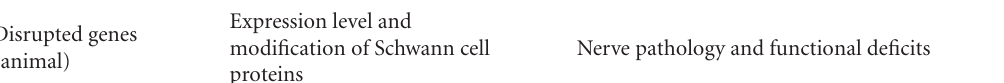
Table 1: Loss-of-function studies for DGC